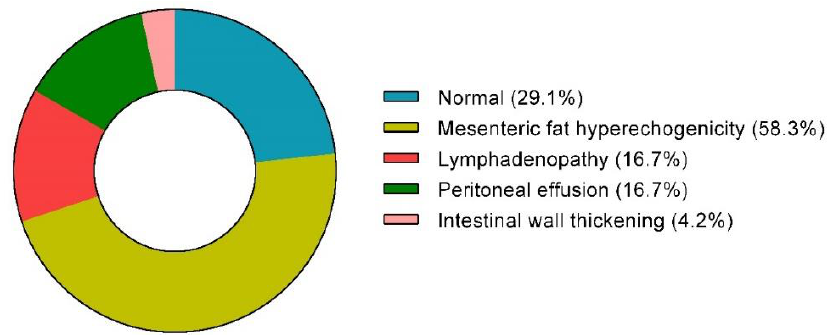
Figure 3. Abdominal ultrasounds’ findings in SARS-CoV-2-infected children presenting with diar- rhea.